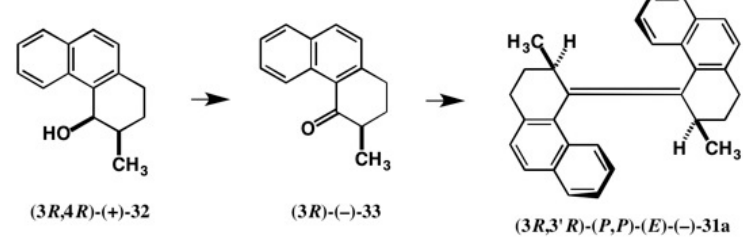
Figure 21. Synthesis of a chiral light-powered molecular motor (3 R ,3’ R )-( P , P )-( E )-( − )- 31a starting from alcohol (3 R ,4 R )-(+)- 32 .